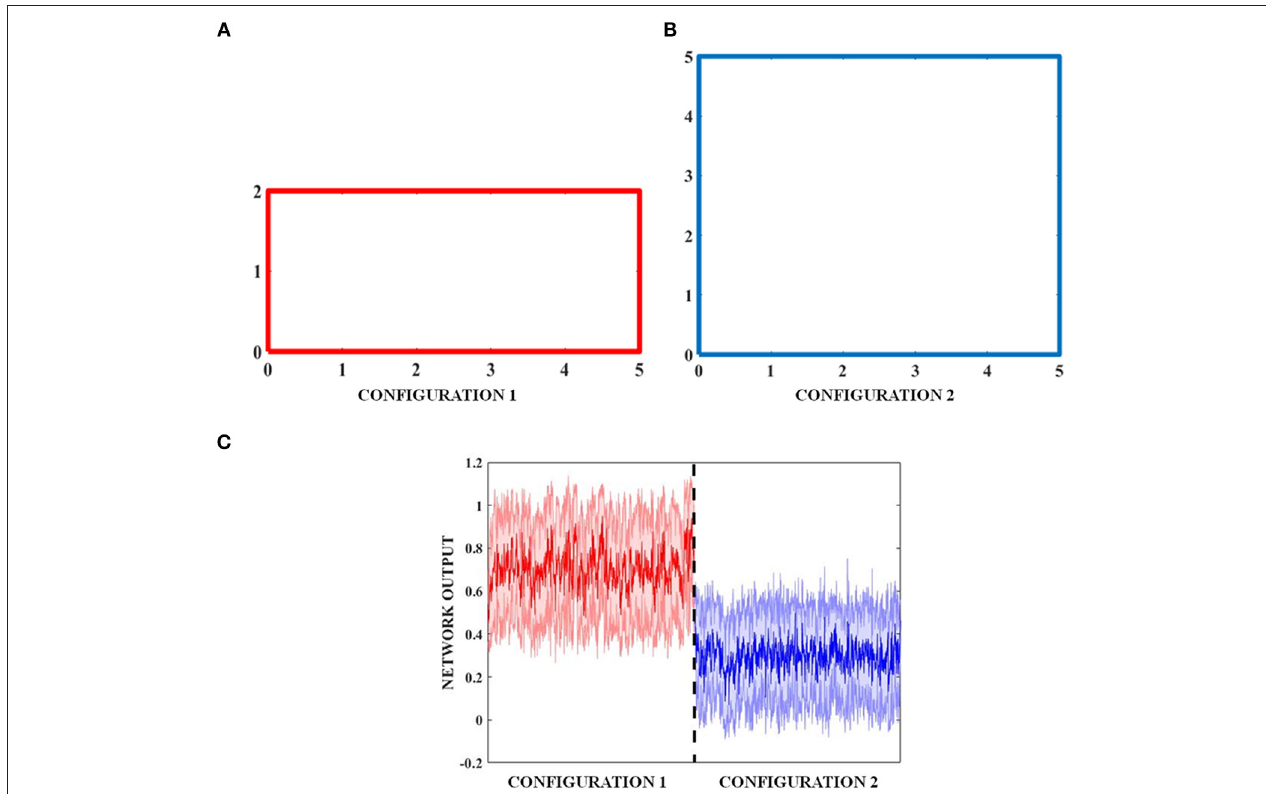
FIGURE 11 | Transforming environment. (A) Rectangle (B) Temporal transformation of the rectangle to a square by increasing its breadth, and (C) shaded plot of the classification of the two boundaries by